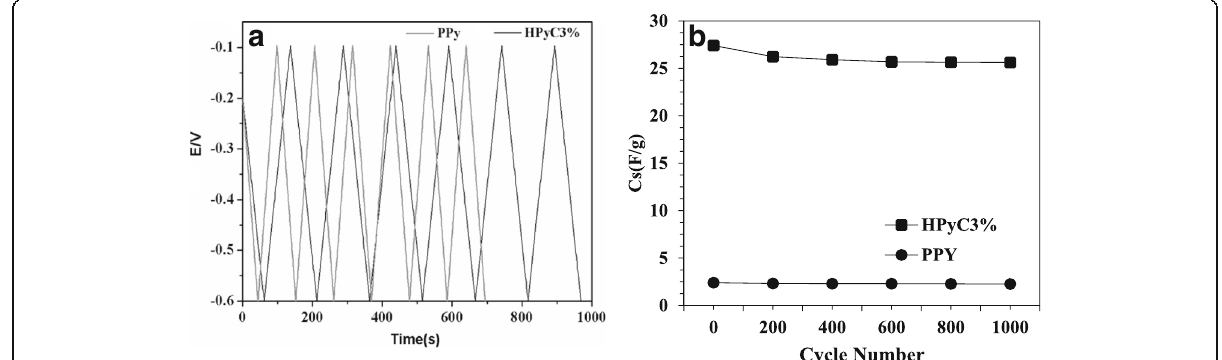
Fig. 6 a Charge-discharge curves. b Effect of number of cycle on the Cs and